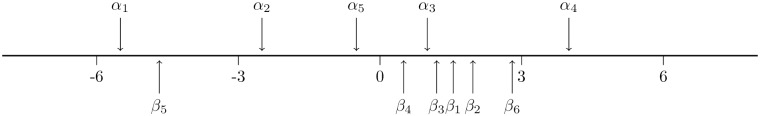
Illustration of ideal point model.Illustration of ideal point model with five respondents and six questions. If a respondent’s latent position αj is greater than the position of the question βk then the probability of an “agree” response (yjk = 1) is greater than 0.5. (This assumes the question’s discrimination parameter γk is positive).